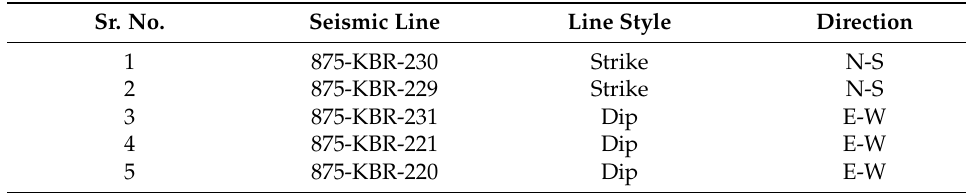
Table 2. Seismic line information. Sr. No.